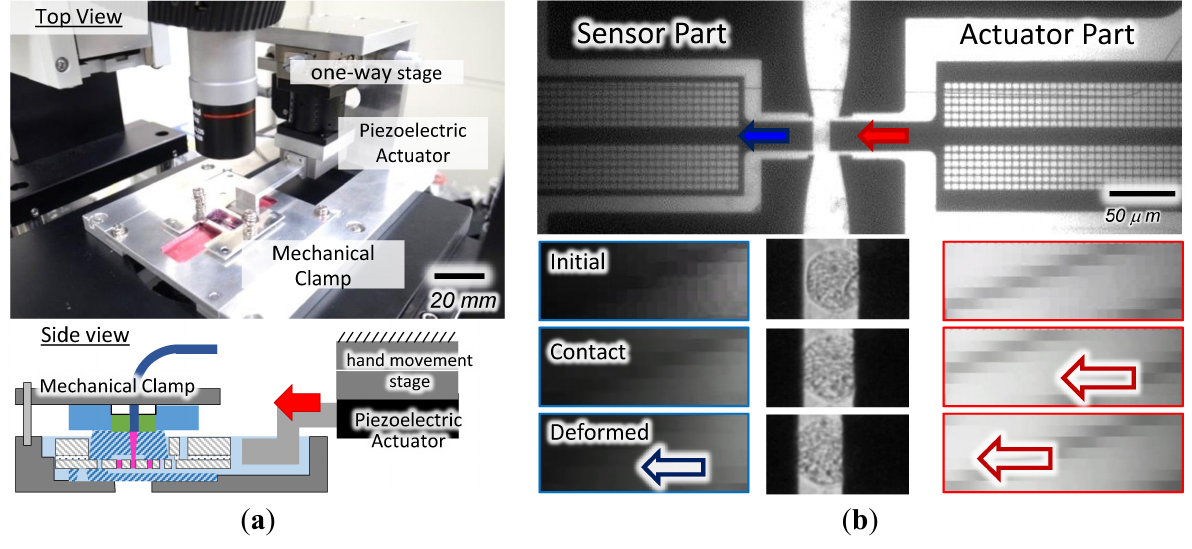
Figure 7. Measurement of cellular mechanical characteristics: ( a ) Image and cross sectional view of the system setup and ( b ) microscopic images at typical points of the measurement.